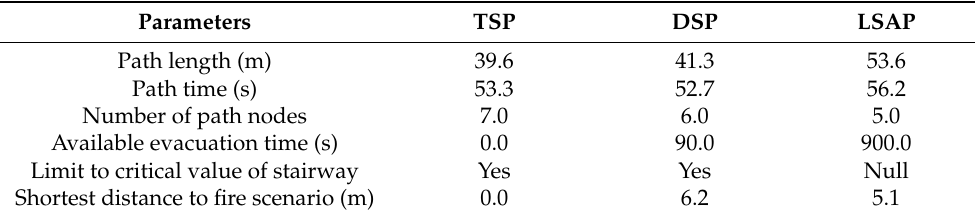
Table 11. Comparative analysis of the parameters of different evacuation passageways in autumn.